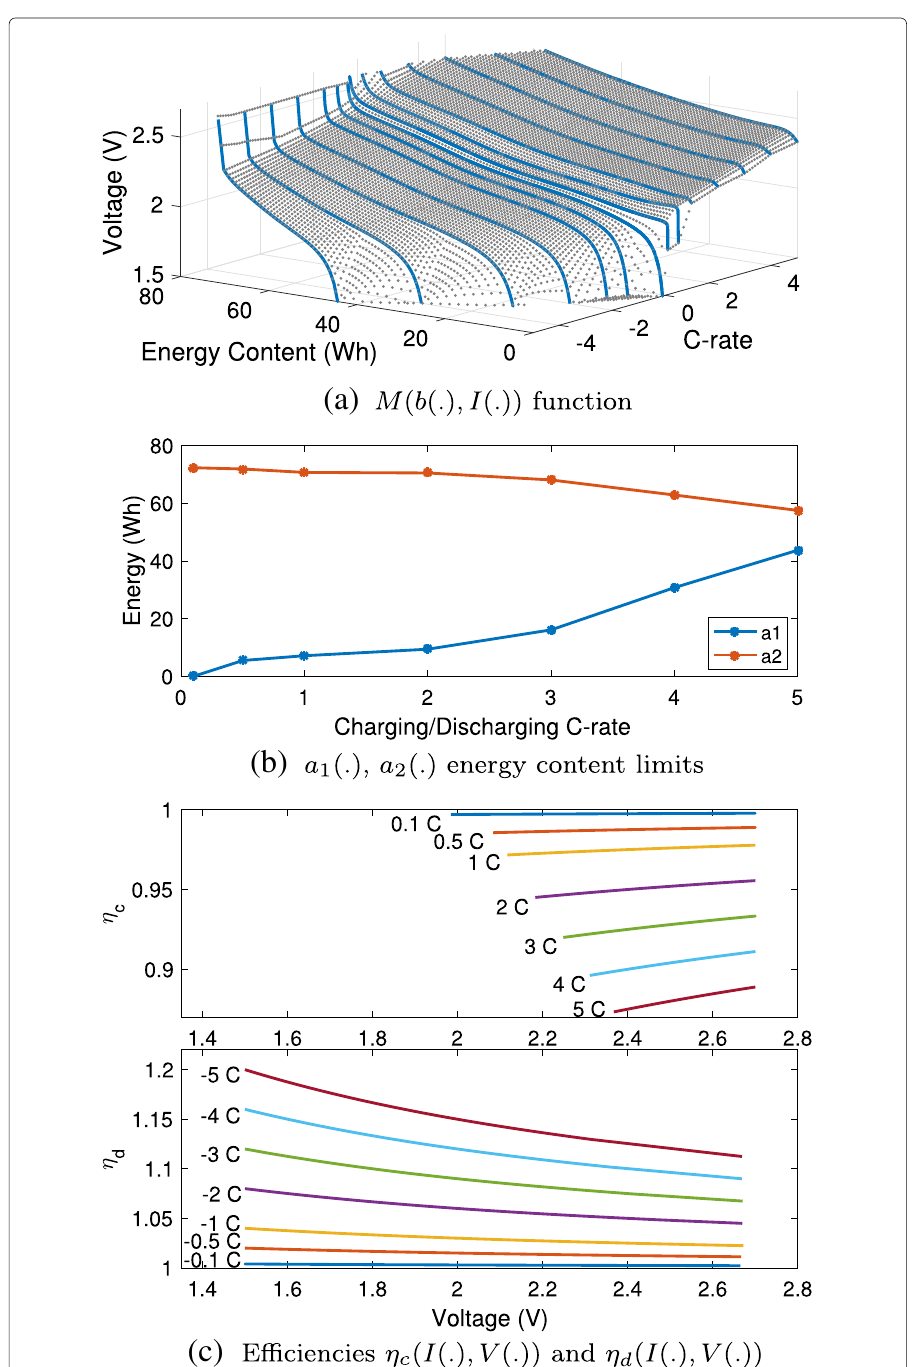
Fig. 1 a M function, which maps the applied current and energy content to a unique voltage, shown with blue curves obtained from a spec and grey points representing the interpolated surface between the curves. b a 1 ( . ) and a 2 ( . ) : points obtained from the spec. c η c ( . ) and η d ( . ) , with each line representing the efficiency at a different C-rate, as per Eqs. 7 and 8